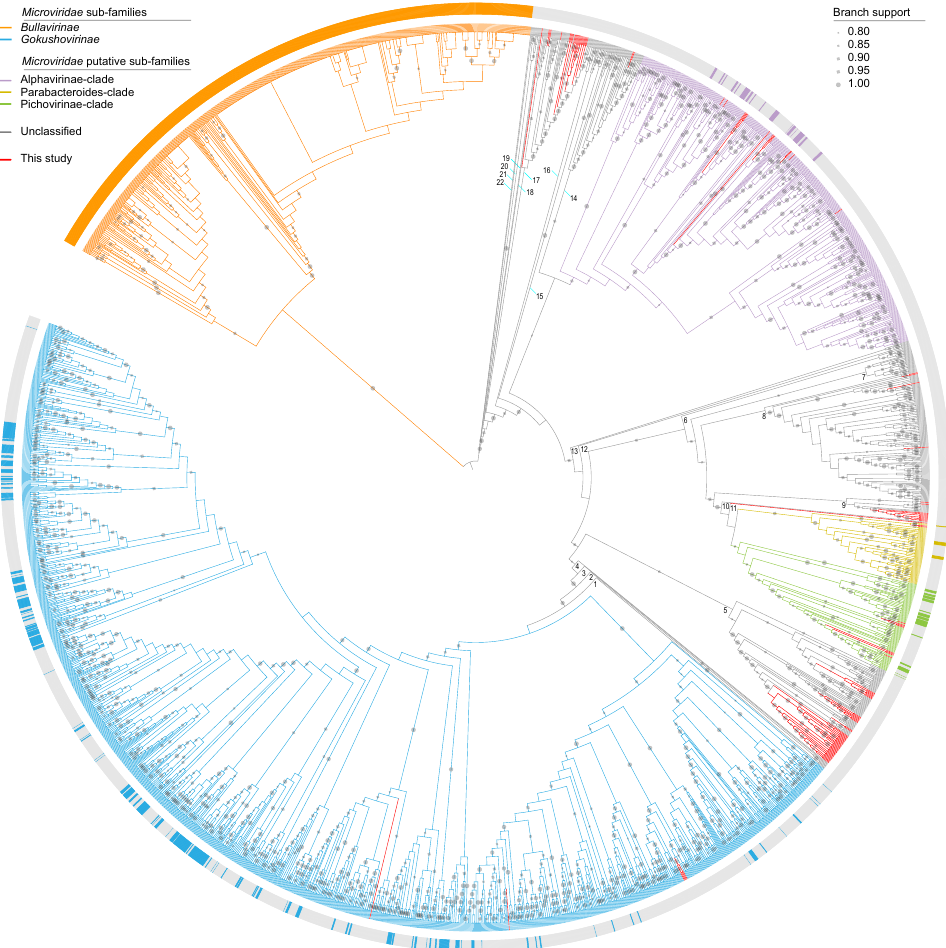
Figure 5. Approximately Maximum-Likelihood cladogram of the MCP sequences ( n = 2797). Branches are color coded based on sub-families ( Bullavirinae and Gokushovirinae ) and Alphavirinae-, Parabacteroides- and Pichovirinae-clades. In addition to these, 22 unique clades are marked with numbers. Branches in grey represent an additional nine singletons and 13 clades. Branches in red denote sequences identified in this study. The outer circle represents taxa with some level of classification assigned prior to this study. Branch support with > 0.8 aLRT is shown. Detailed cladogram and phylogram are provided in Supplementary Figures S1 and S2 and taxa names and assignment are provided in Supplementary Data